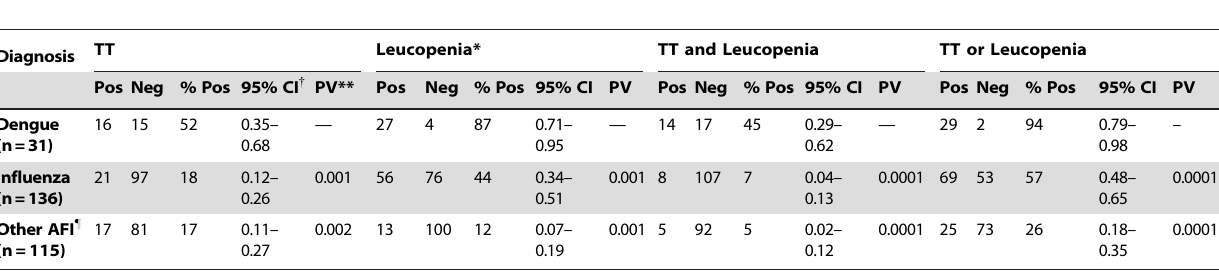
Table 1. Tourniquet test and leucopenia results among patients with dengue, influenza or other AFI.